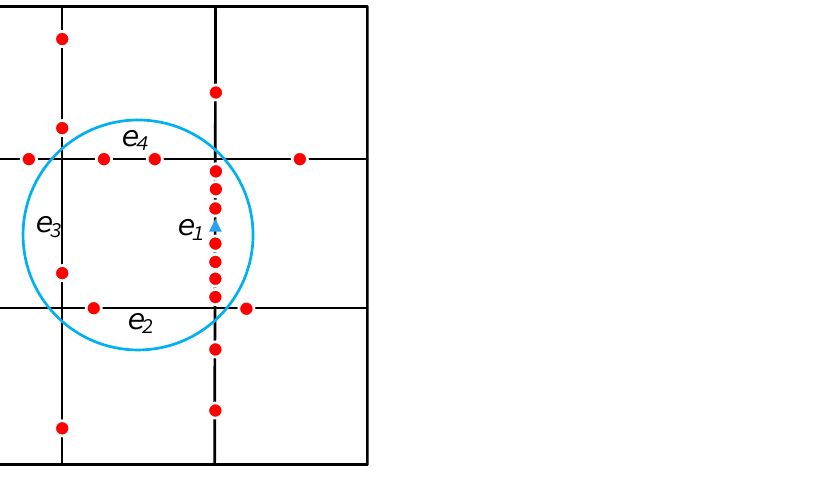
Figure 4. Side weight inference attack based on the background knowledge of user